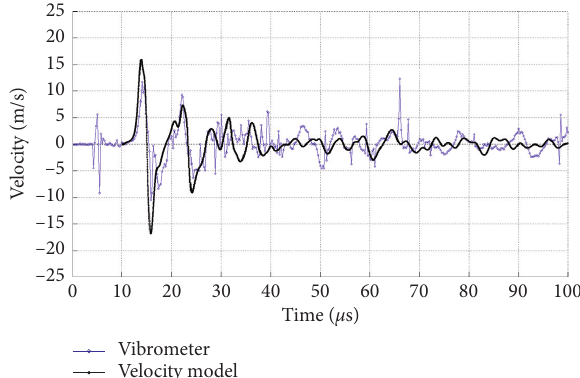
Figure 24: Results of the medium-intensity test on Inermet ® 180, acquired hoop strain (blue) with smoothing function and simulated signal (black).